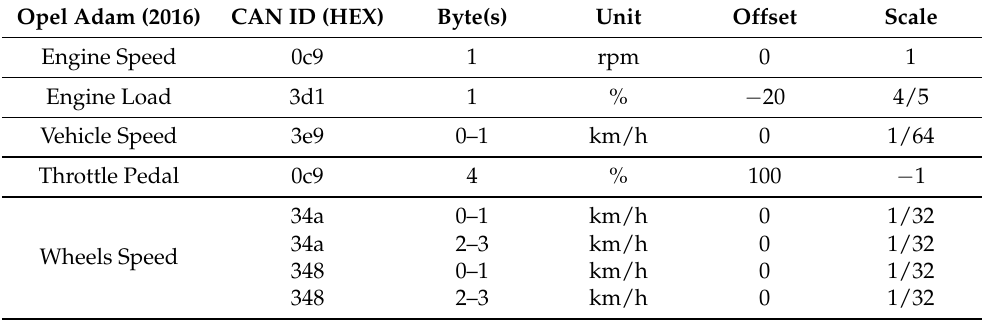
Table 4. Identified parameters on Opel Adam (2016) with its respective features.